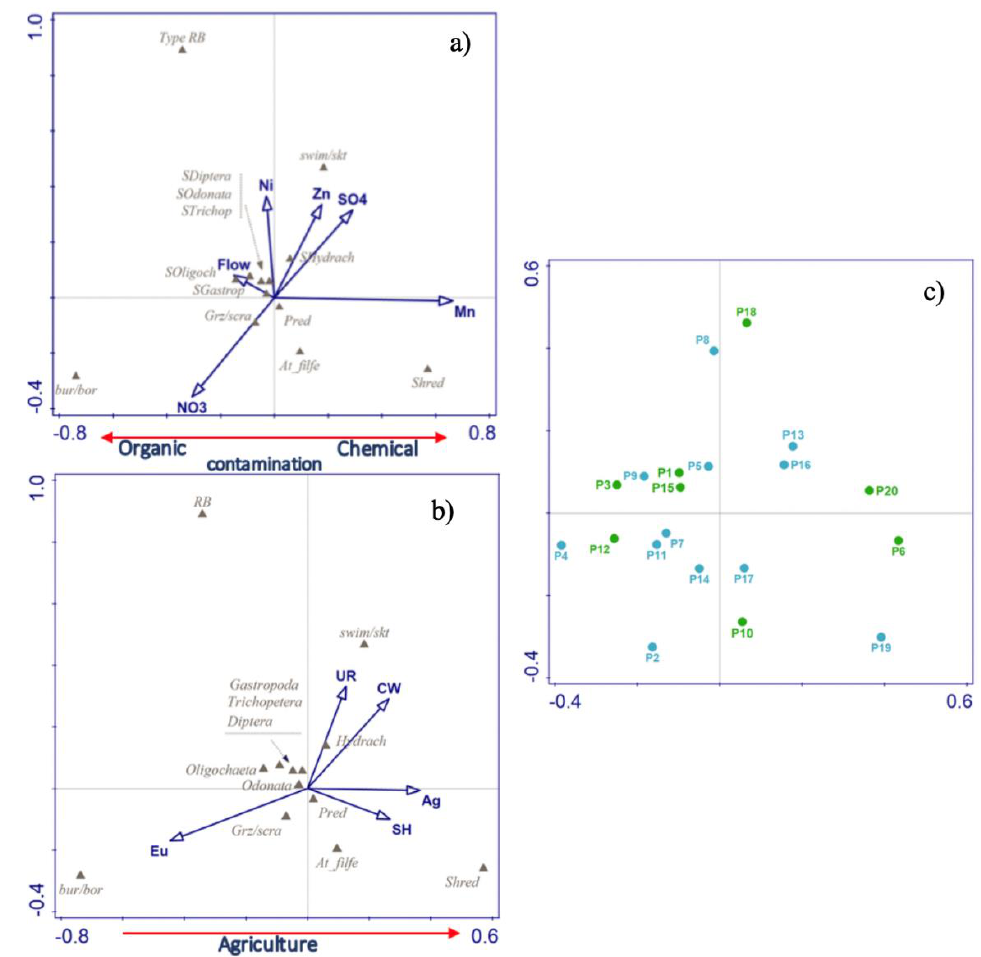
Figure 11. Correspondence Analysis (CA) bi-plot, in the ordination space of first and second axis, of the macroinvertebrate traits and ( a ) physicochemical variables; and, ( b ) Land-use land cover variables. ( c ) CA plot with the 20 sampling sites from the Paiva catchment. Only significant and independent environmental variables and more fitted traits are shown. The red arrows show the direction of the disturbance gradient and are common to all diagrams. Sites, taxa and environmental codes are given in Tables 1 and S2—Electronic Supplementary Material.